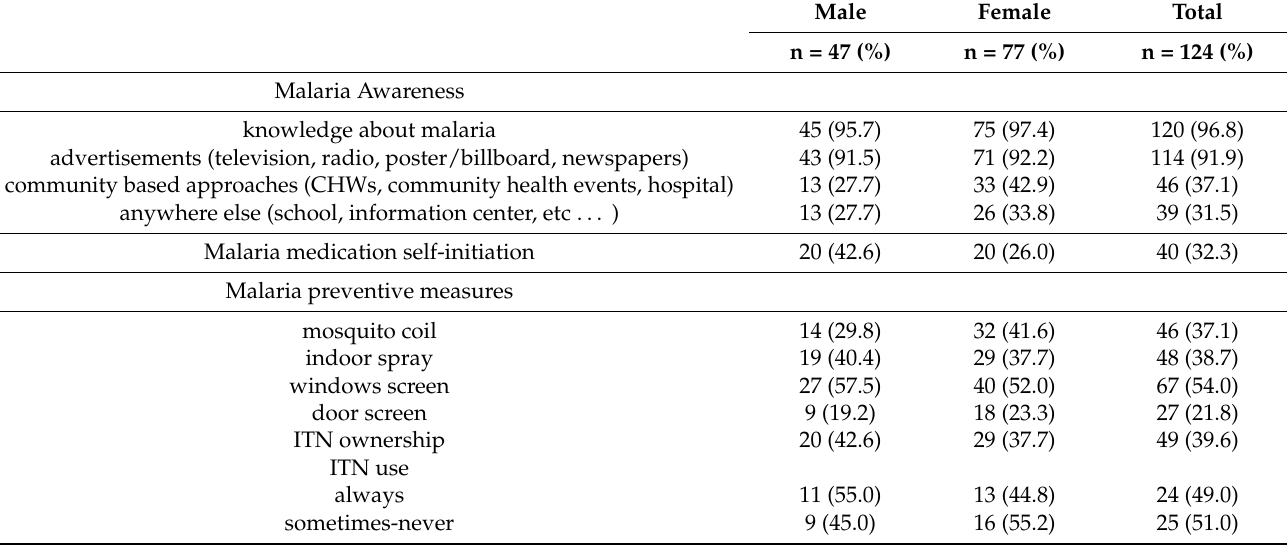
Table 3. Malaria awareness, exposure behaviors and preventive measures among cases (male vs. female).